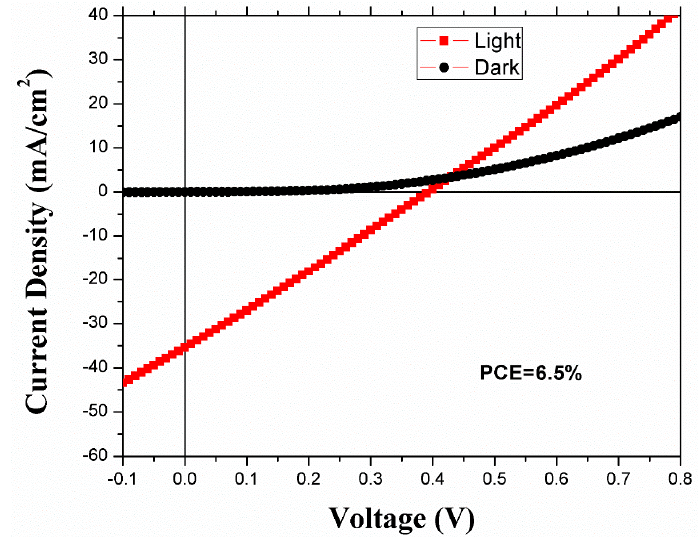
Figure 6. The J–V characteristics of the seven-layered spin-coated device.